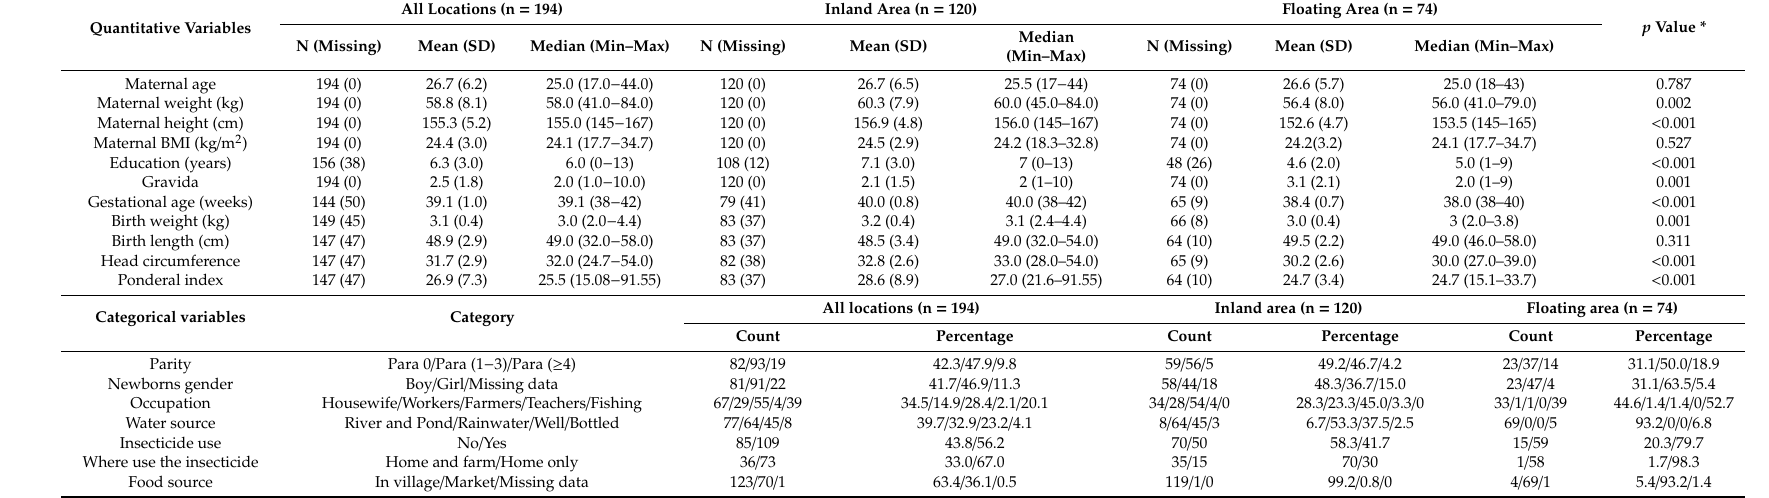
Table 1. Sociodemographic and anthropometric characteristics of studied